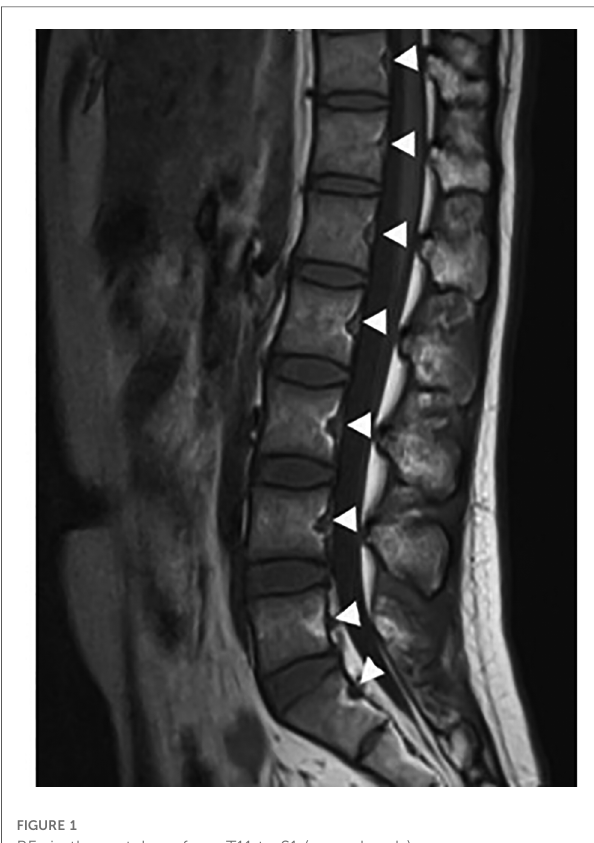
FIGURE 1 BFs in the vertebrae from T11 to S1 (arrow